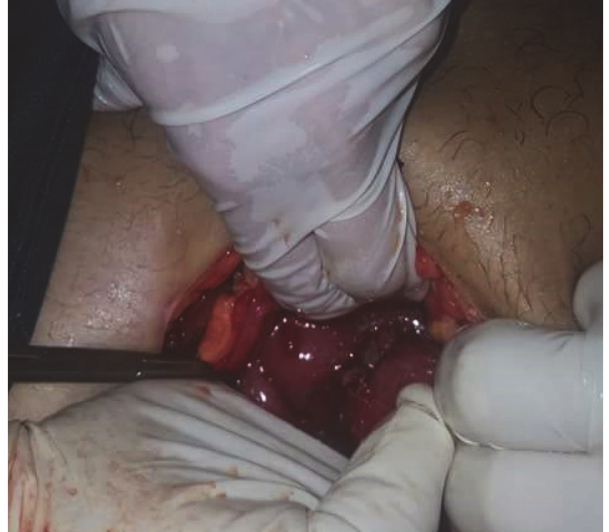
Figure 3: Repair of site of ectopic pregnancy and suction of